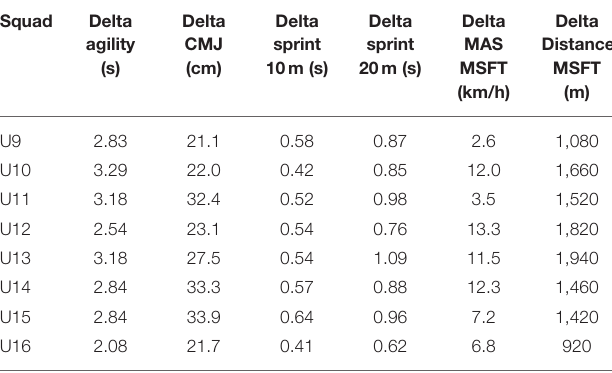
TABLE 4 | Delta values indicate variation for physical parameters as agility, jump performance (CMJ), sprint capacity (10 m/20m) and endurance capacity (MSFT) after